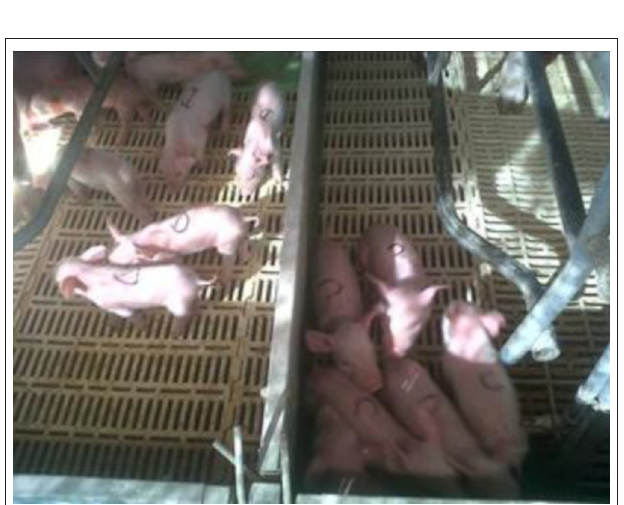
FIGURE 2 | Visual representation of colibacillosis clinical signs and associated diarrhea in Experiment 2. Piglets in the ESV vaccinated group displayed normal behavior and were absent of clinical signs (Left) , while piglets in the Control group huddled together and were lethargic (Right) .